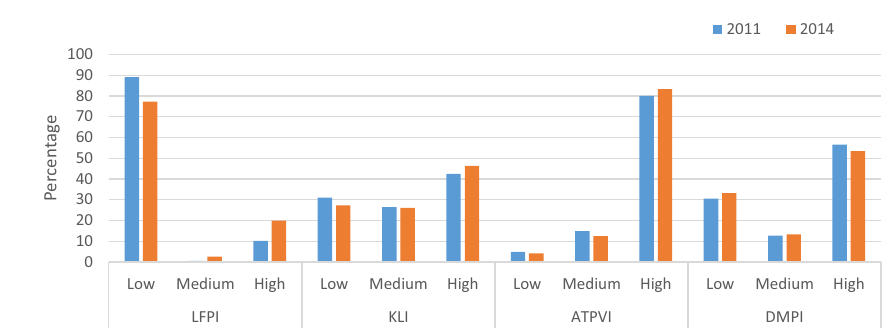
Figure 1. Prevalences of healthcare facilities by survey years